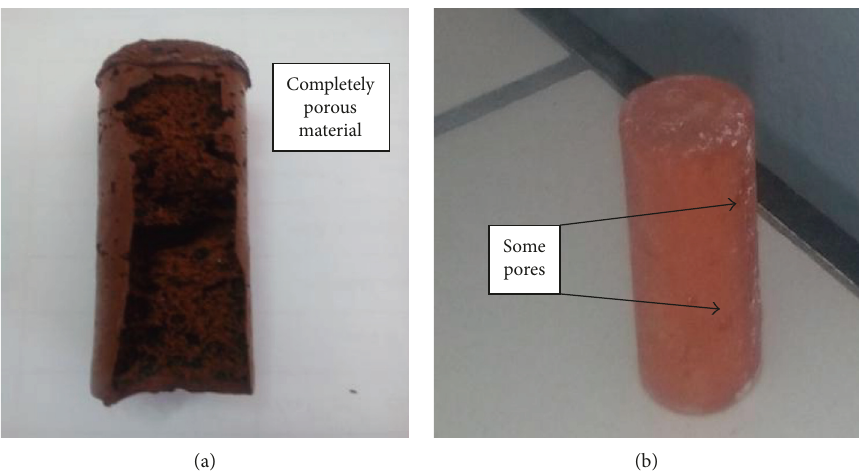
Figure 8: Photographs of obtained geopolymer foam (a) and geopolymer cement (b).